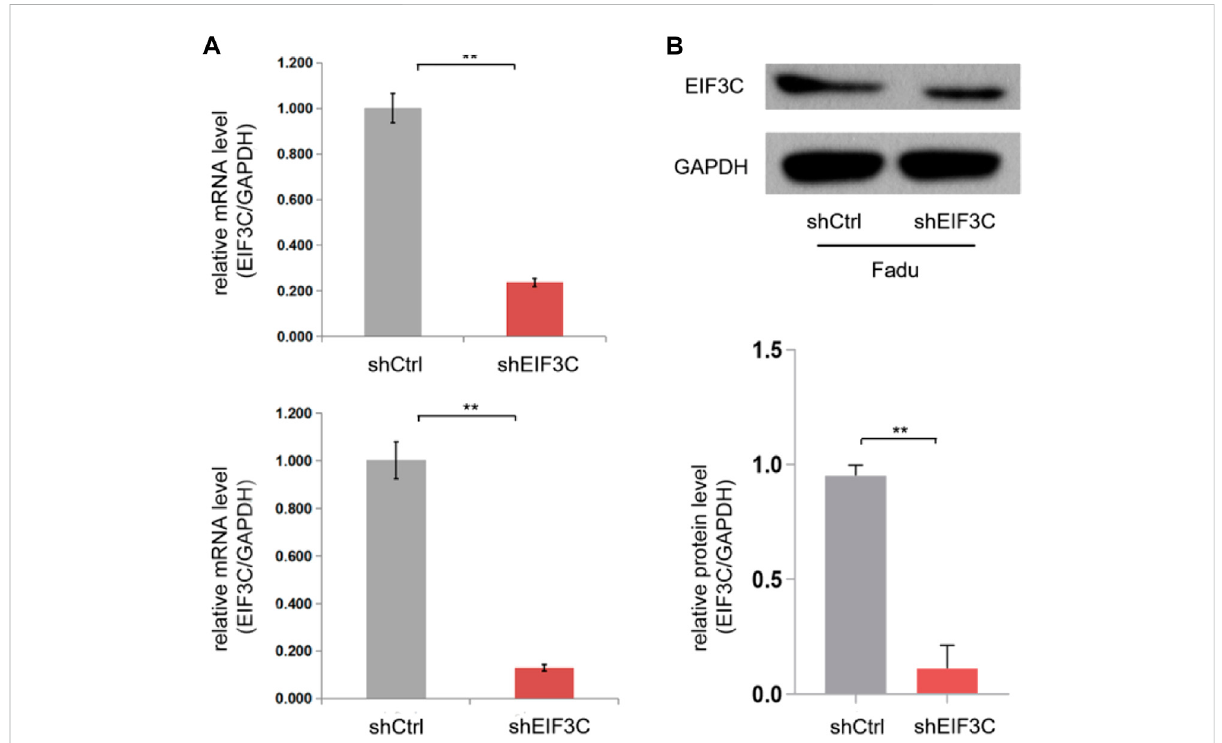
FIGURE 1 The L.v-shEIF3C decreased the expression of EIF3C in FaDu and 5-8F cells. (A) qRT-PCR analysis showed that the L.v-shEIF3C signi fi cantly decreased the mRNA expression of EIF3C in FaDu and 5-8F cells. (B) Western blot showed that the L.v-shEIF3C signi fi cantly decreased the protein expression of EIF3C in FaDu cells, the grey scale of the protein bands was analyzed with ImageJ software. The data is the means ± SDs of three independent experiments. The differences were statistically signi fi cant. ** p <